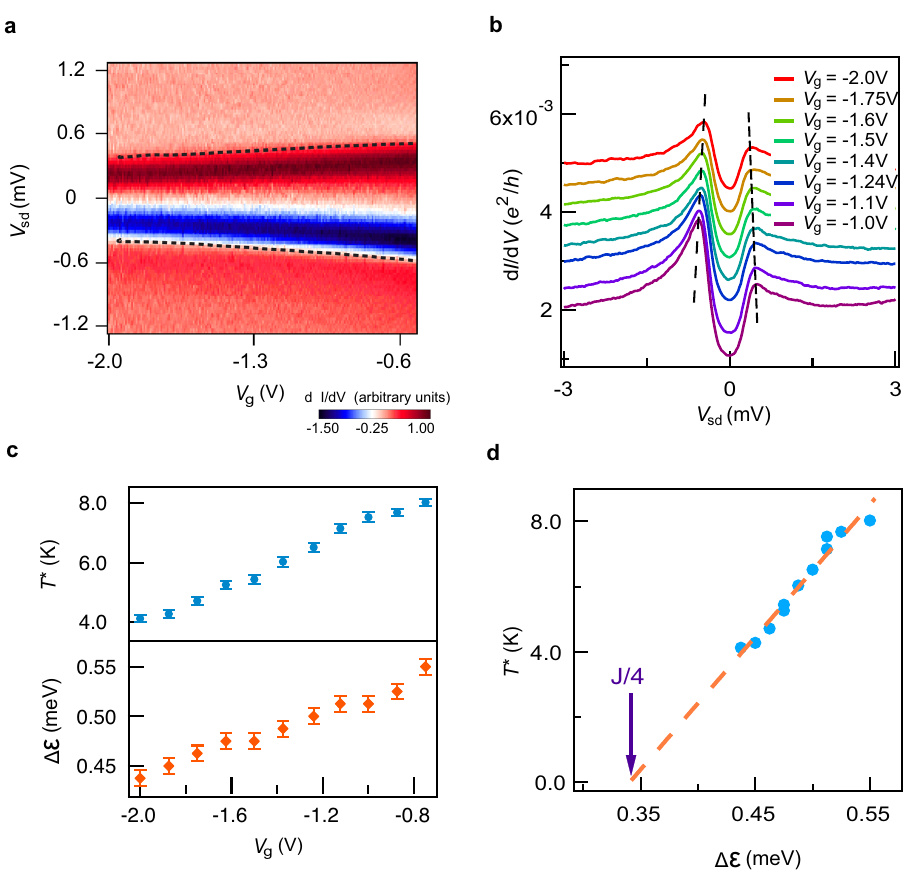
Fig. 3 Gate voltage dependences of T * and singlet – triplet energy splitting. a Color plot of the numerical derivative of d I/ d V as a function V sd and V g in region II for device 1. The black dash line indicates the peak positions, which corresponds to the energy difference between spin singlet and triplet. b Line traces of d I /d V against V sd in a at different gate voltages. The peak positions are marked by a dash line. The curves are shifted vertically for clari fi cation. c T * and Δε of device 1 at different gate voltage. The error bars of T * represent the uncertainty of the fi tting result using Eq. (1). Δε is acquired by taking the peak position of the split peaks at different gate potentials in b and the uncertainty is also represented by error bars. d Plot of T * against Δε for device 1. The dash line is a linear fi